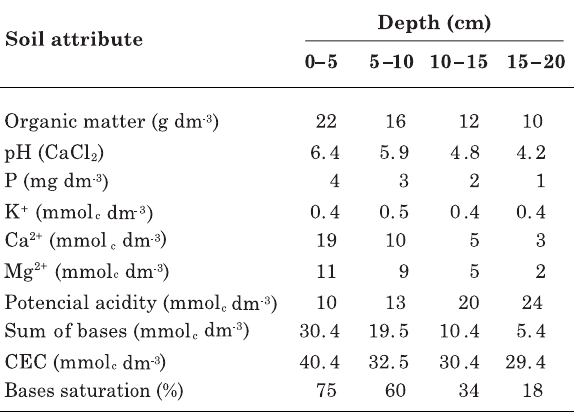
Table 1. Chemical analysis of the soil, six months after liming at the time of sowing alley